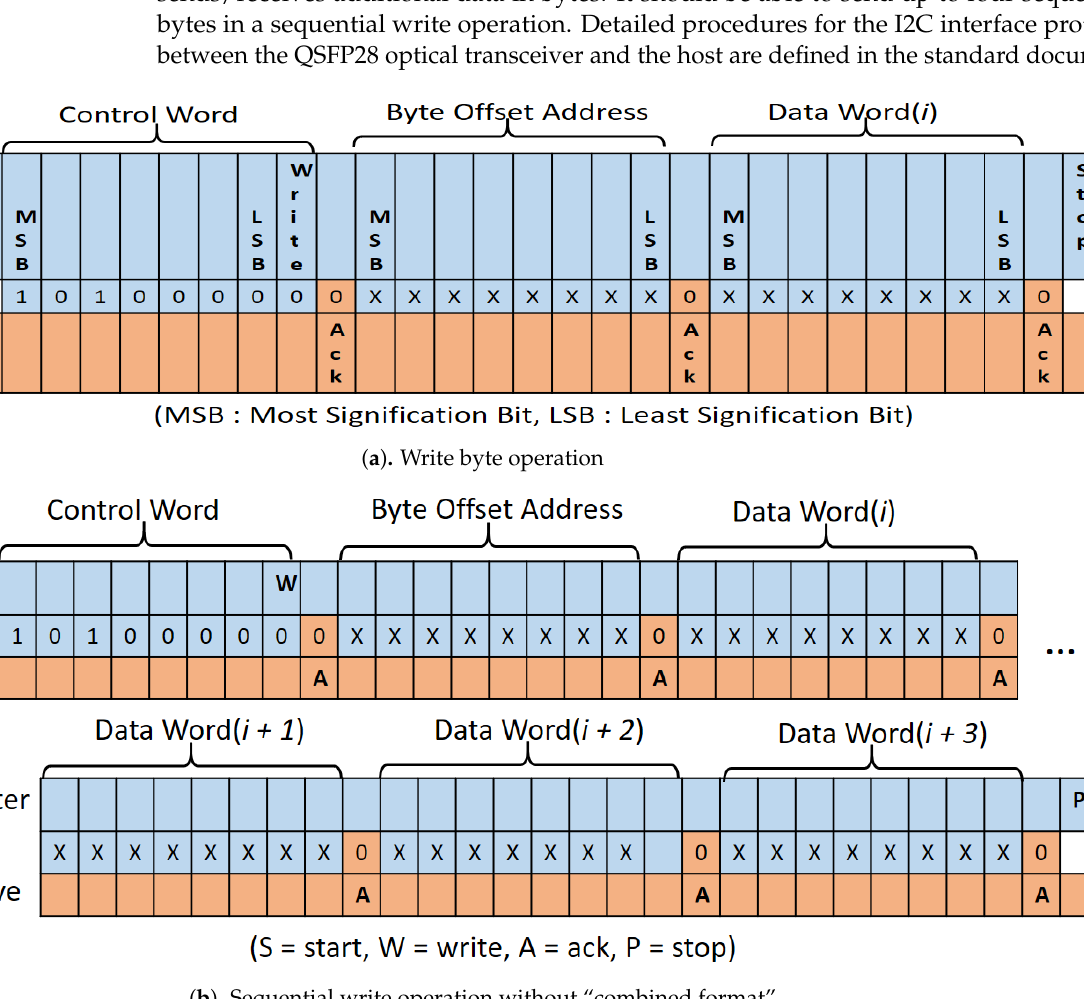
Figure 3. QSFP28 host two-wire interface (write operation)